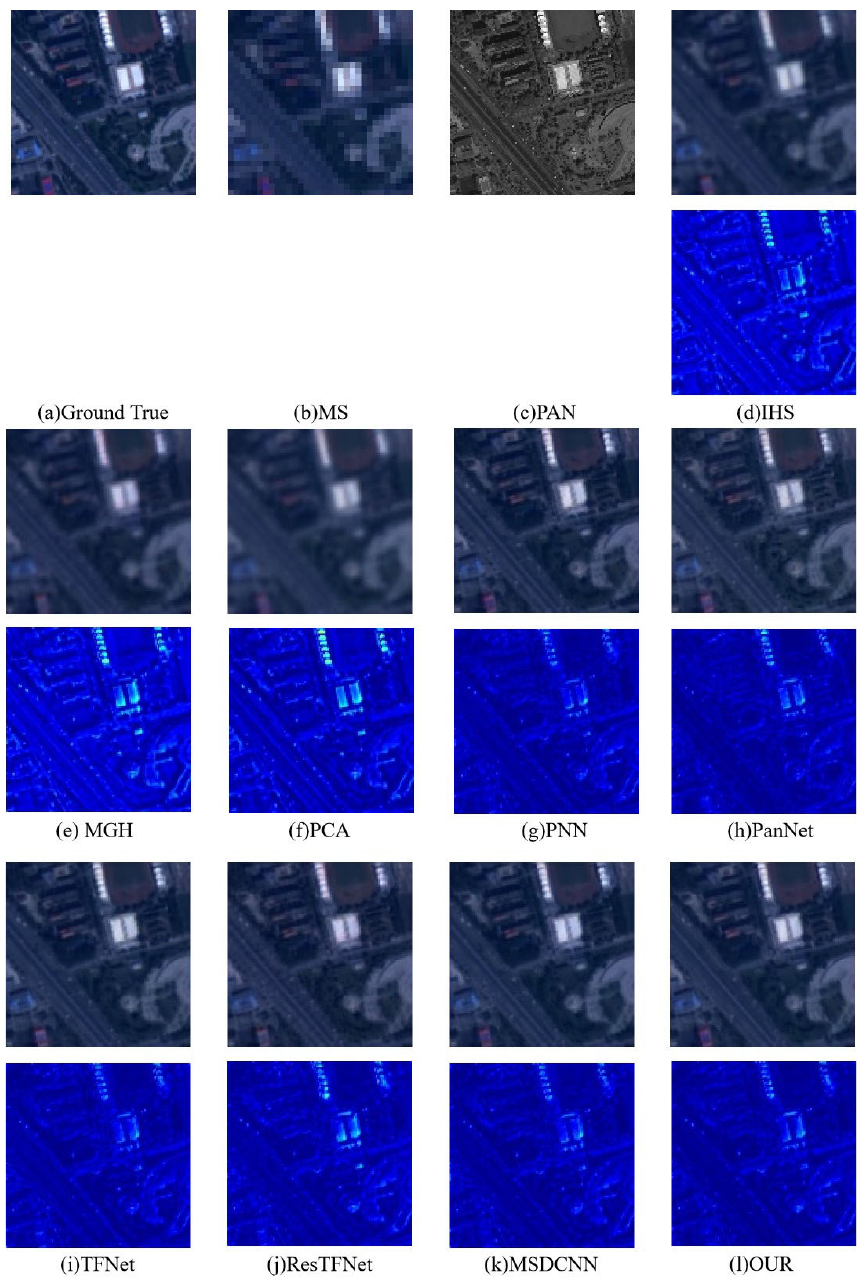
Figure 7. Pansharpening results on the GaoFen-2 satellite dataset. The first line is the fusion result of the GaoFen-2 image, and the second line is the image obtained by pseudo-coloring the differences between the fusion result of the first line and the ground truth RGB image (that is, ( a )). All images are displayed in true color (red, green, and blue being the three